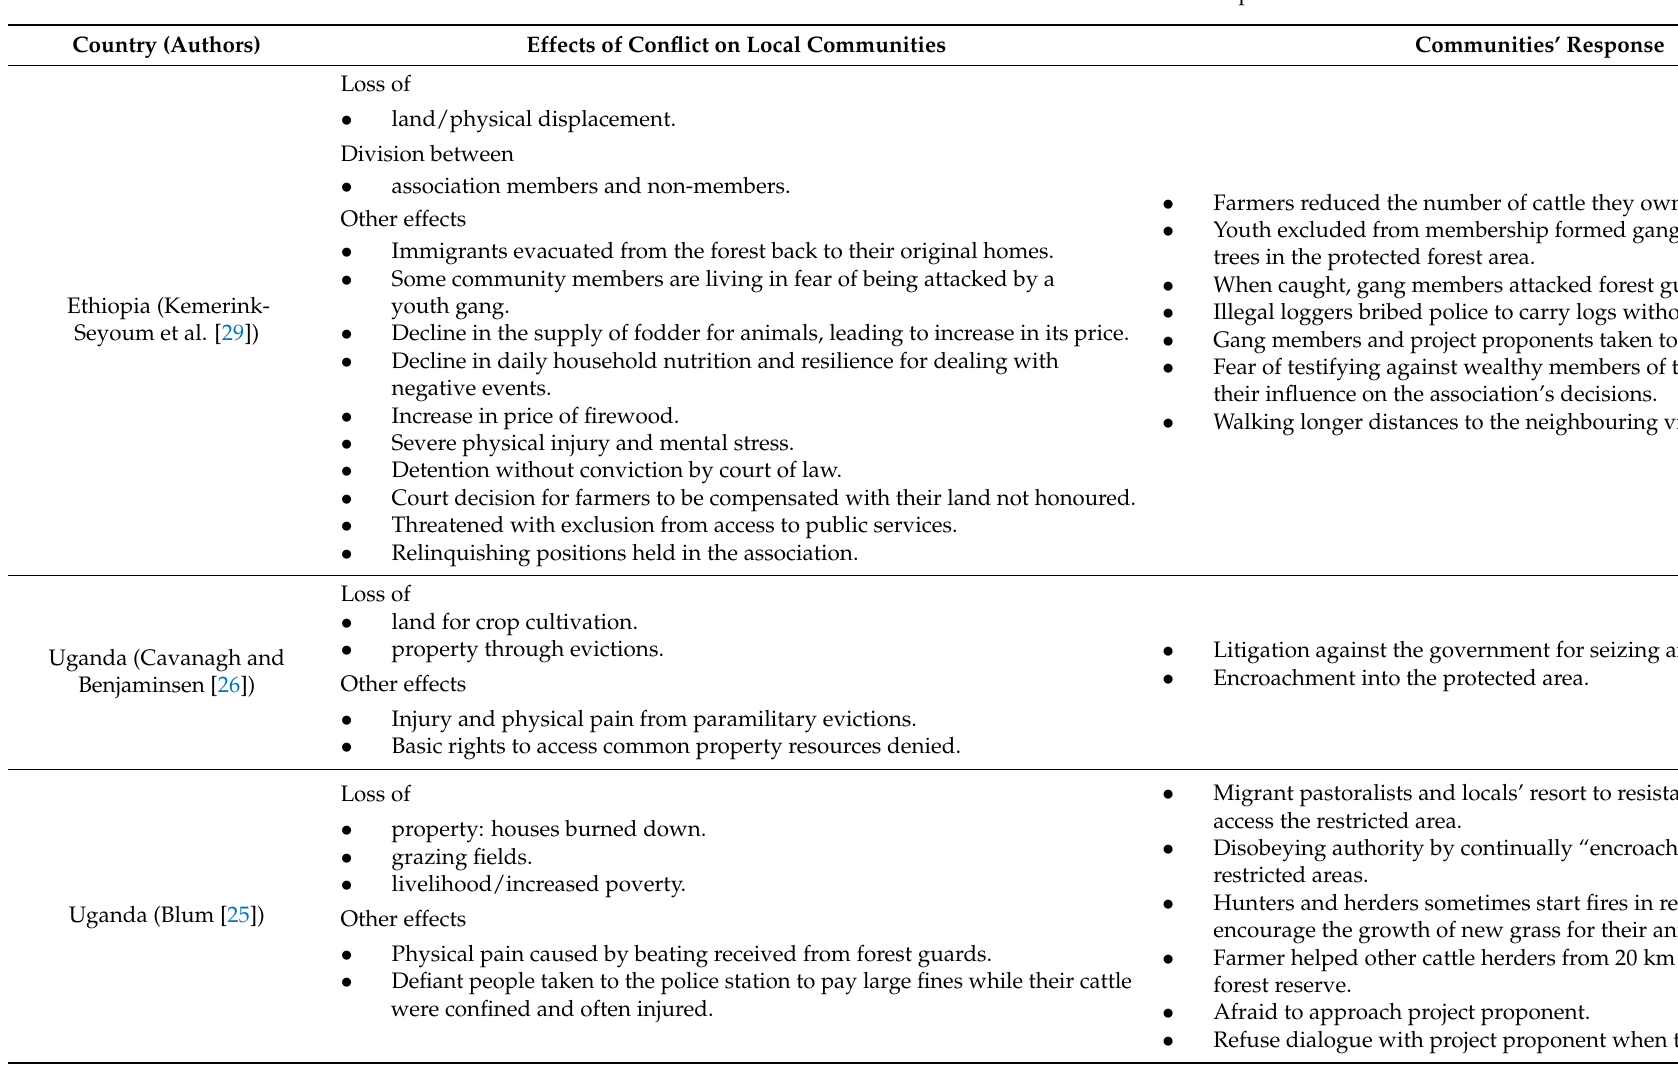
Table 2. Effects of conflicts on local communities and their